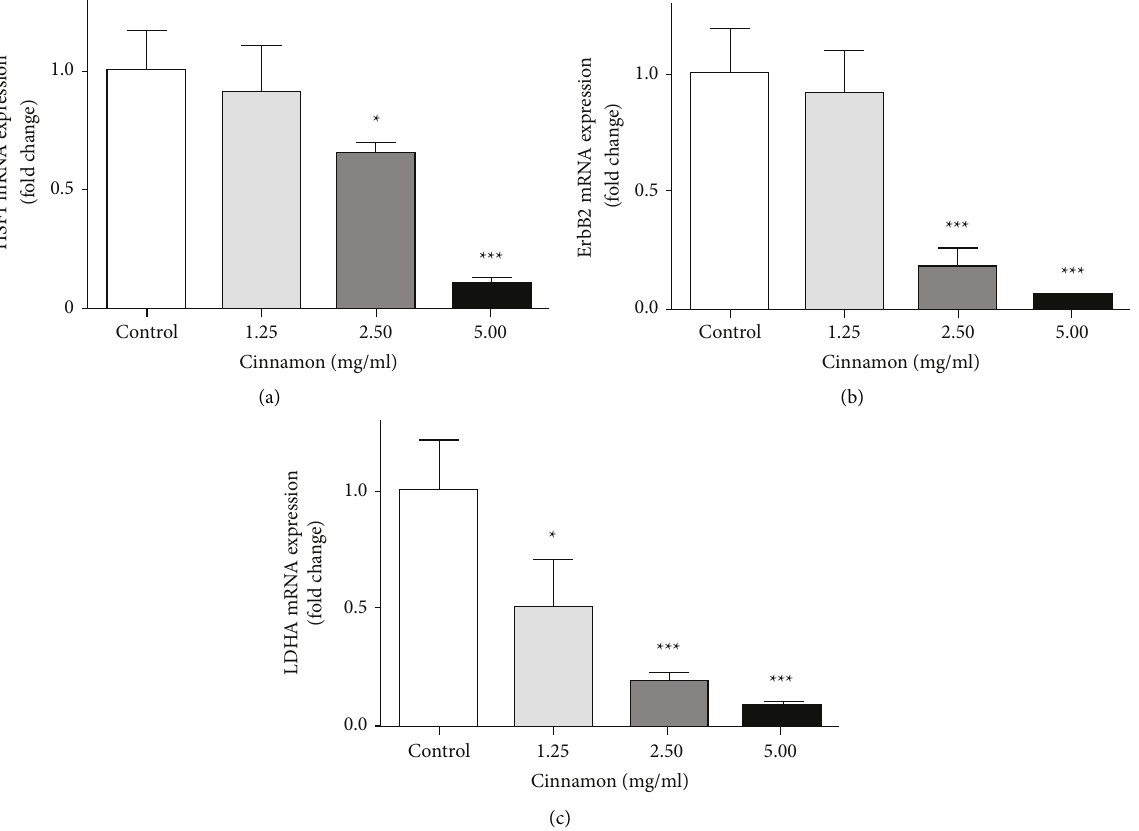
Figure 3: Effect of different concentrations of Cinnamon aqueous extract on mRNA expression (fold change) of HSF1 (a), ErbB2 (b), and LDHA (c). Data are represented as the mean ± SD. Each value is the average of at least three independent replicates. ( ∗ P < 0 . 05, ∗∗∗ P < 0 . 001compared to the control group). ErbB2: human epidermal growth factor receptor2, HSF1: heat-shock transcription factor1, LDHA: lactate dehydrogenase